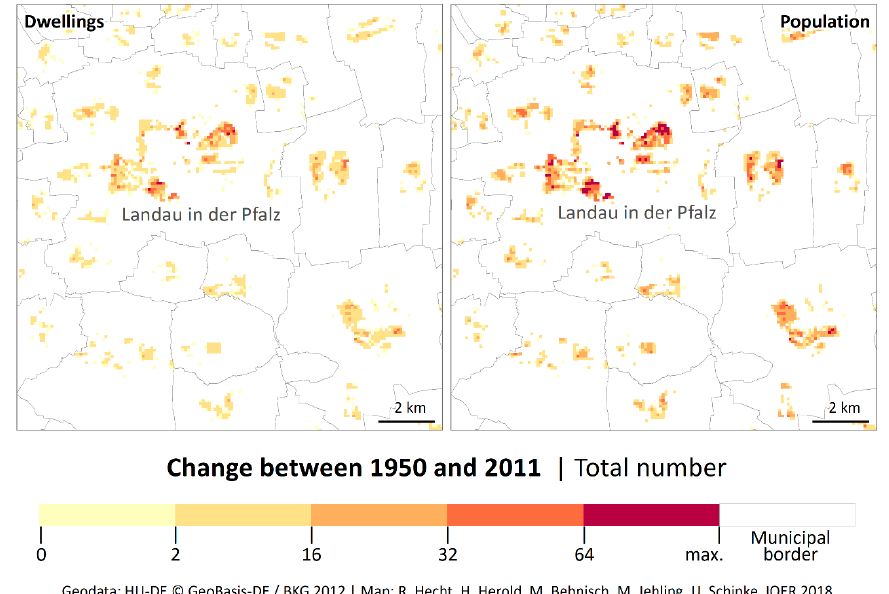
Figure 6. Automatically processed dynamics in dwellings ( left ) and population ( right ) at the level of 100 m grid cells for the central part of the study area.